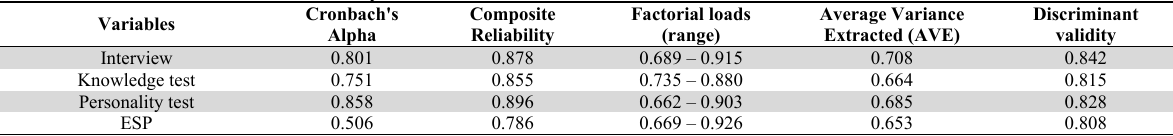
Results of the model measurement analysis Variables